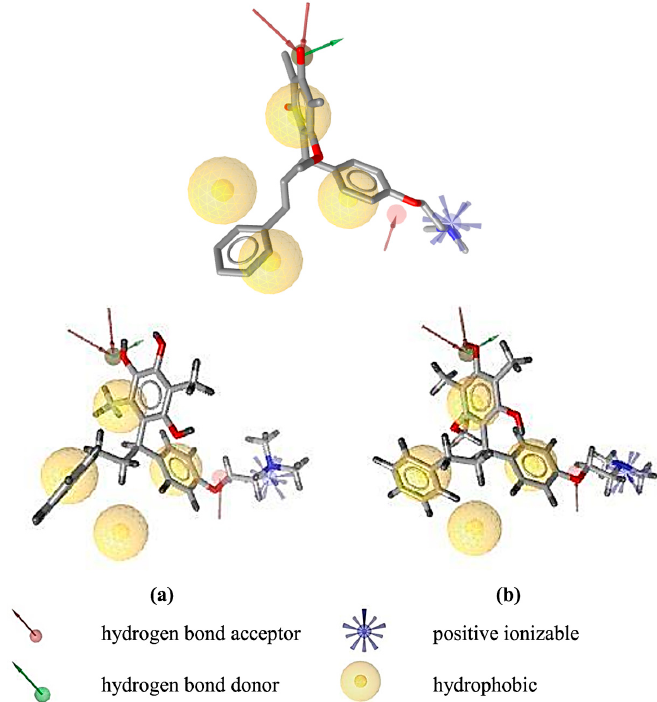
Figure 7. Fit of the ( a ) HNS9 ( b ) HNS10 to the structure-based pharmacophore model derived from 4-OHT with ER α from PDB code: 3ERT. The models were generated using LigandScout 4.1 Advanced. Virtual screening was performed leaving at least two features out. The ligands fit six of the eight features and all of the excluded volumes.